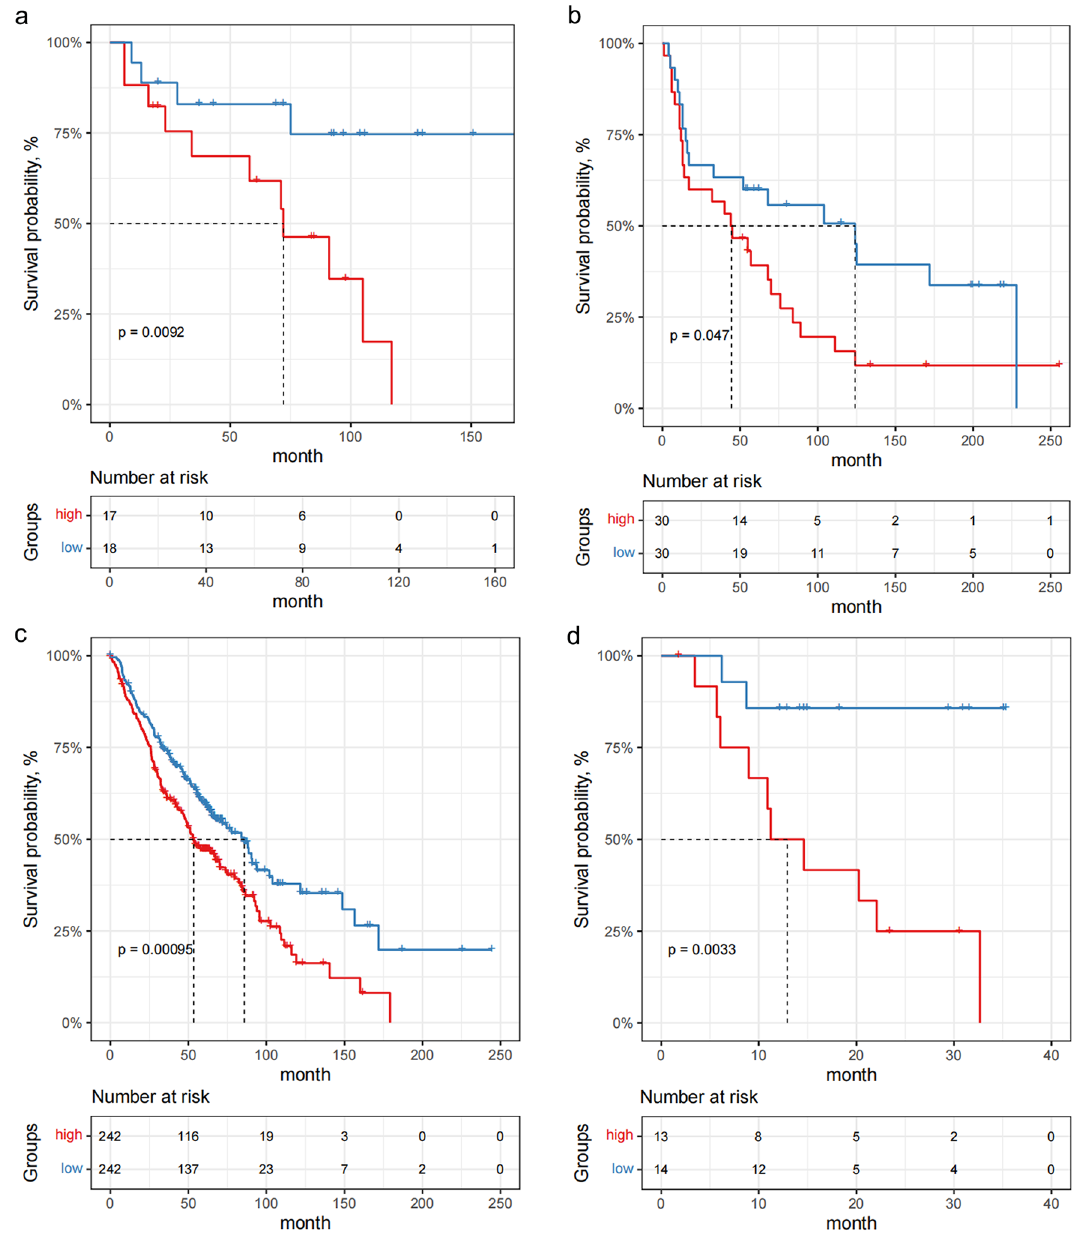
Figure 7. Re-sampling analyses in Gene Expression Omnibus datasets (GSE30219, GSE12472, GSE157011 and GSE78220) implicate the reliability of the 13-gene signature for predicting overall survival of LUSC patients. ( a ) Kaplan–Meier survival curves for overall survival in the lung squamous cell carcinoma (LUSC) immunotherapy dataset GSE12472. The p value is based on the log-rank test. ( b ) Kaplan–Meier survival curves for overall survival in the LUSC immunotherapy dataset GSE31210. The p value is based on the log-rank test. ( c ) Kaplan– Meier survival curves for overall survival in the LUSC immunotherapy dataset GSE157011. The p value is based on the log-rank test. ( d ) Kaplan–Meier survival curves for overall survival in the melanoma immunotherapy dataset GSE78220. The p value is based on the log-rank